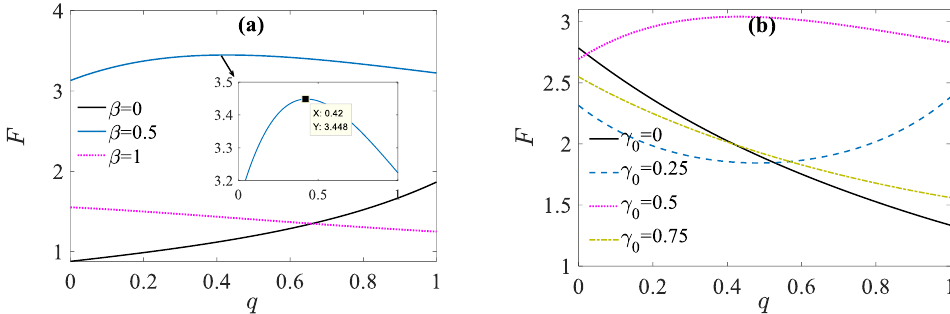
Figure 12. GSR induced by the order of fractional damping under different noise coefficients and damping intensity. ( a ) γ 0 = 0.5, ( b ) β = 0 . 5